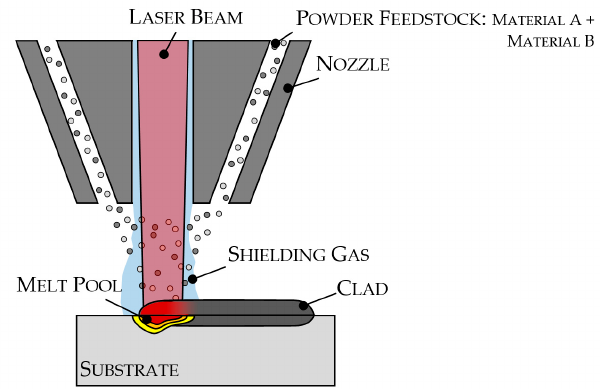
Figure 1. Working principle of laser-directed energy deposition (L-DED) for multimaterial deposition.